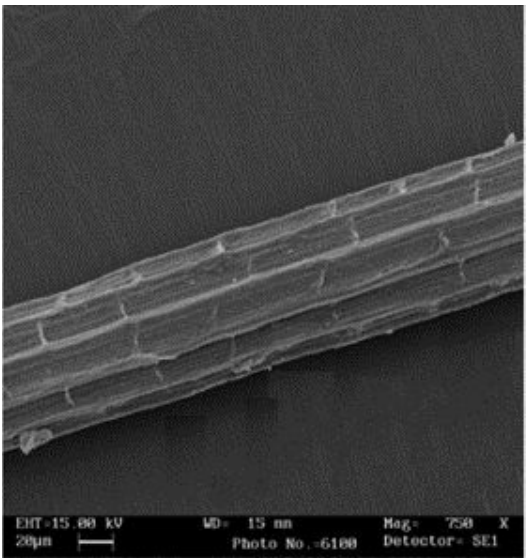
Figure 5. SEM micrograph 750x of treated Curauá fibres with 5% NaOH for 4